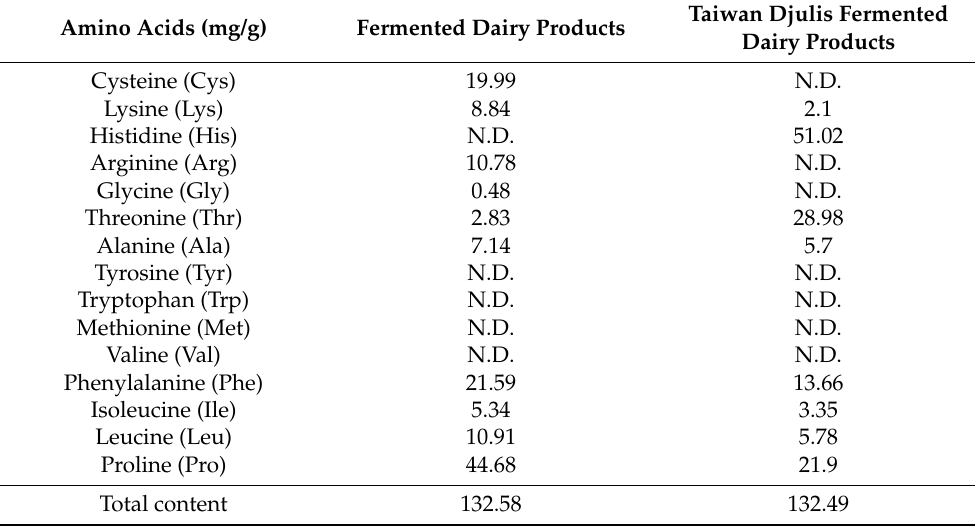
Table 2. Free amino acid content in fermented dairy products and Taiwan djulis fermented dairy